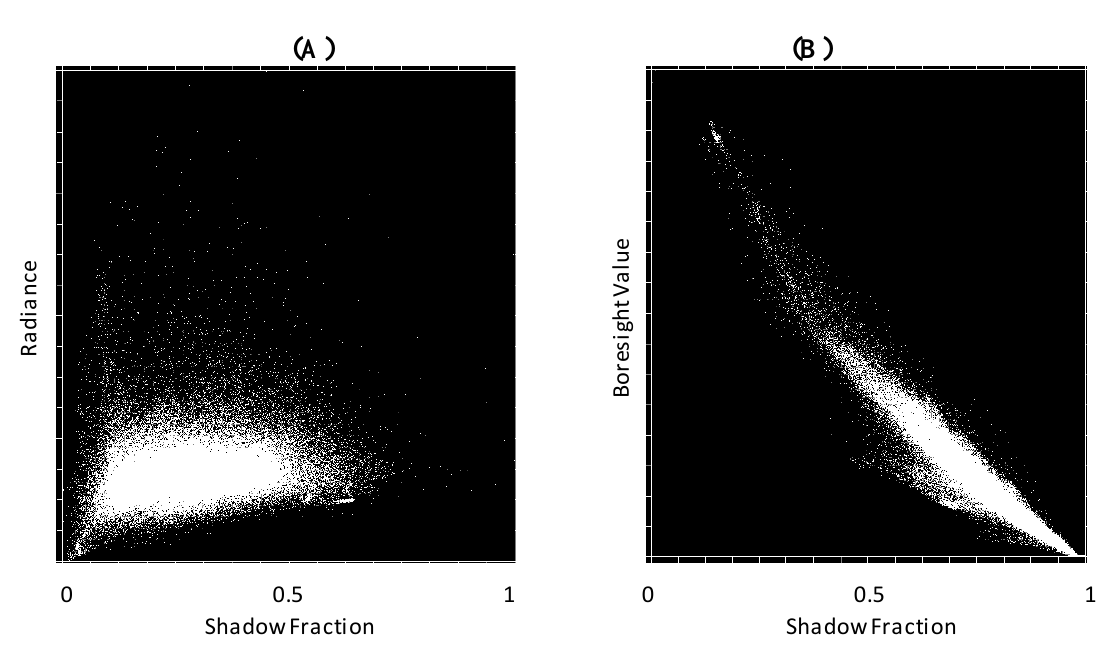
Figure 5. Relationship between shadow fraction and ( A ) radiance spectra (550 nm) detected by ATCOR-4 algorithm ( 𝑦 = 944𝑥 + 1411 ; 𝑅 2 is 0.173), ( B ) boresight values of detected shadow areas ( 𝑦 = −0.74𝑥 + 1.31 ; 𝑅 2 is 0.913).